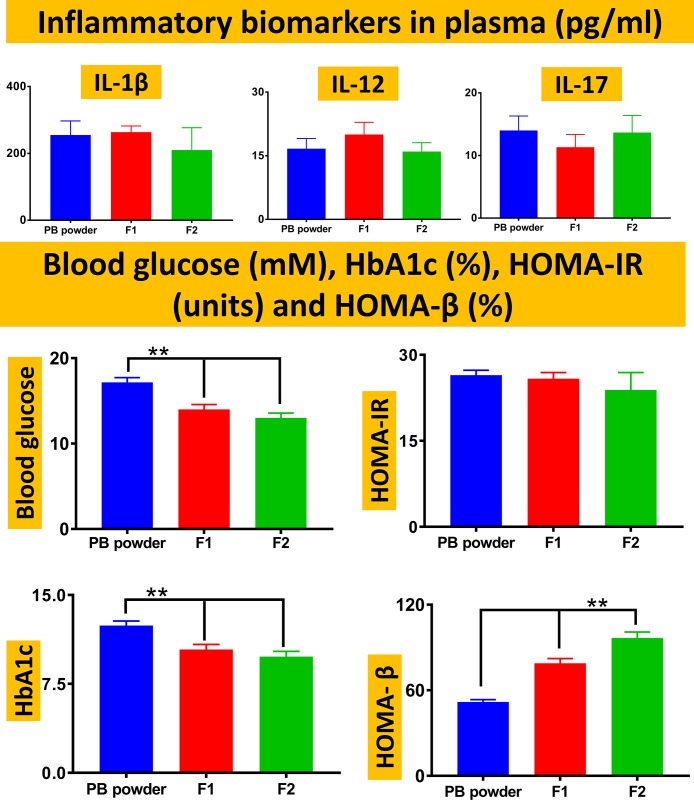
Plasma inflammatory biomarkers, blood glucose, glycated haemoglubin (HbA1c), homeostatic model assessment (HOMA) for insulin resistance (HOMA-IR) and β-functions (HOMA-β).Data are mean ± SEM. ** p < 0.01.